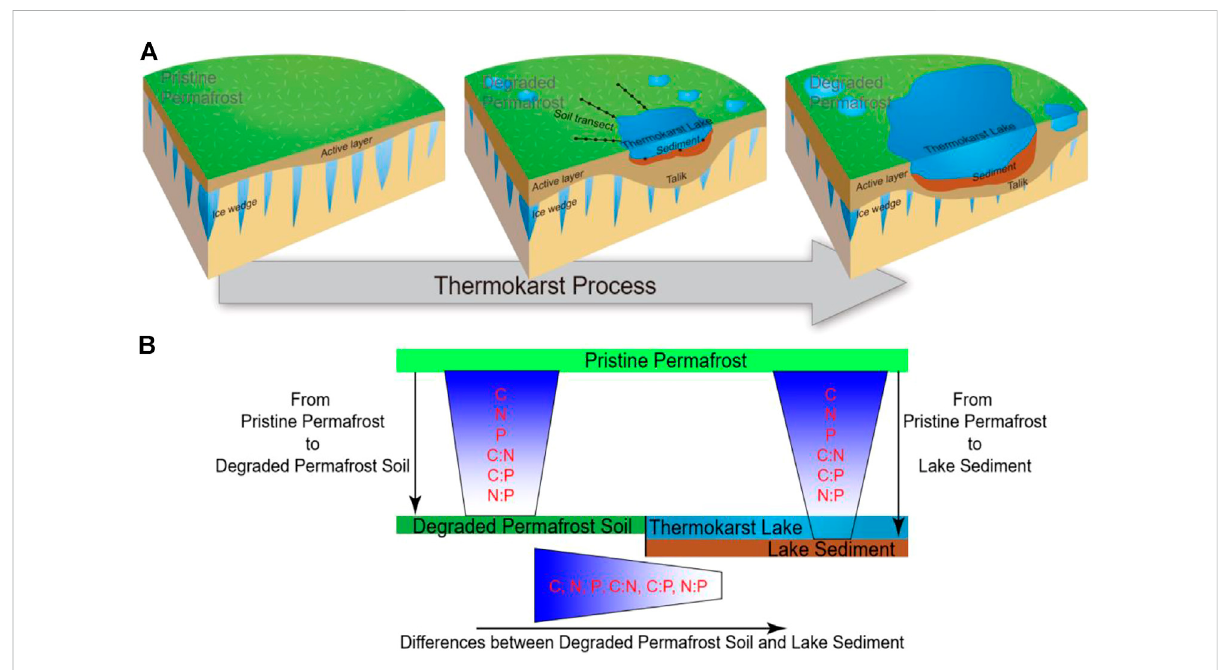
FIGURE 2 (A) Theprocessofthermokarstlakeformationinice-richpermafrost(citedfromRenetal.,2022).Thesamplingstrategyareshowninthemiddle plot. (B) A schematic view of the C:N:P stoichiometry in degraded permafrost soil and thermokarst lake